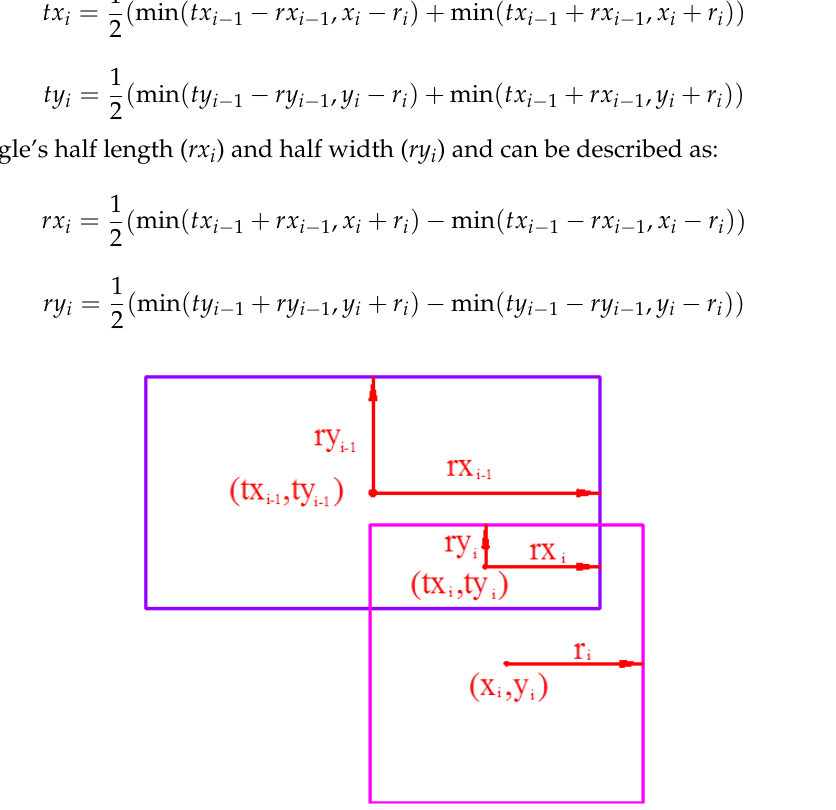
Figure 3. Iteration process of the square intersection.